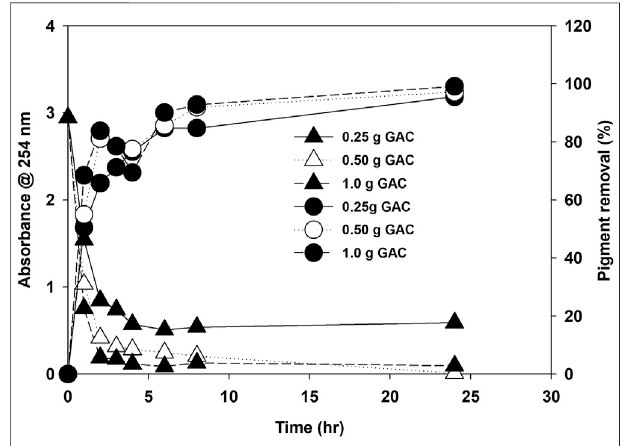
FIGURE 8 | Removal of organic carbon ( A 254 nm ) and pigments ( A 440 nm ) at different amounts of granular activated